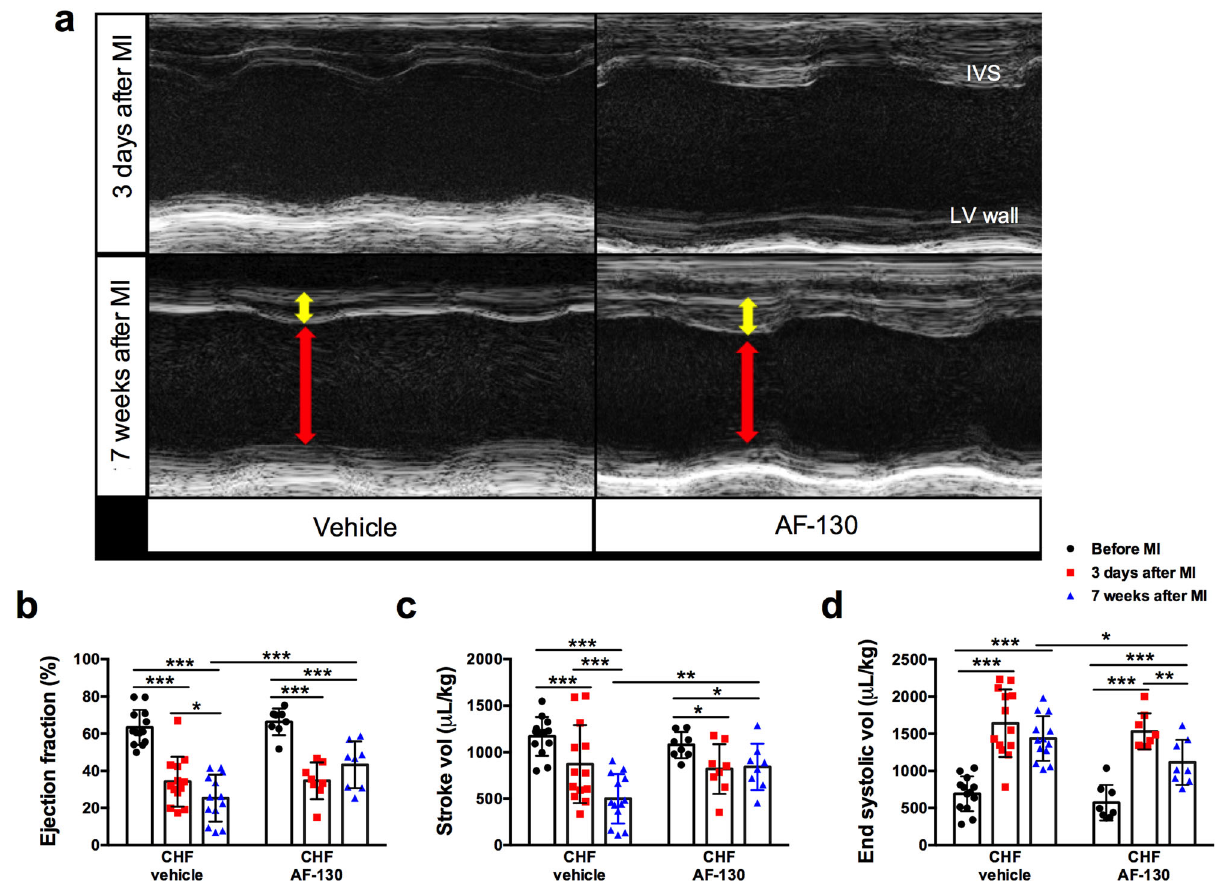
Fig. 6 | P2X3-receptor antagonism improves cardiac function in chronic heart failure(CHF)rats.a Representativeimagesof echocardiographyinratssubmitted tomyocardialinfarction(MI),beforeandafter7weeksoftreatmentwithvehicleor AF-130. Red arrows indicate diastolic ventricular diameter and yellow arrows indi- cate diastolic ventricular wall thickness. P2X3-receptor antagonism prevented the reduction of ejection fraction ( b ) and stroke volume ( c ) during HF development,